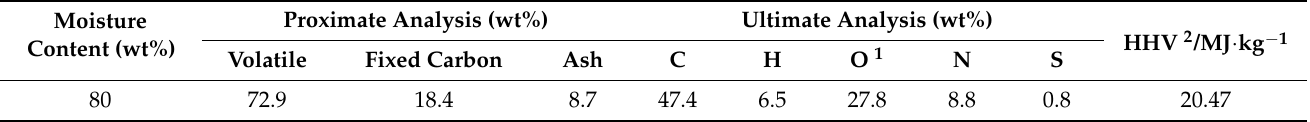
Table 1. Proximate and ultimate analyses of Chlorella on a dry basis [16]. Moisture Proximate Analysis